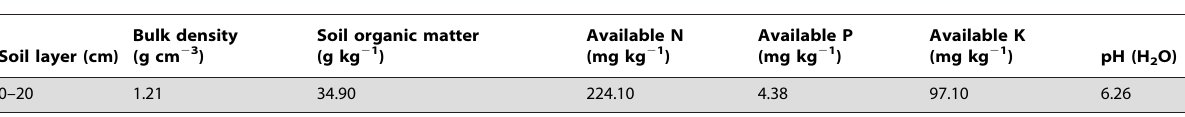
Table 1. Principal soil properties of the test